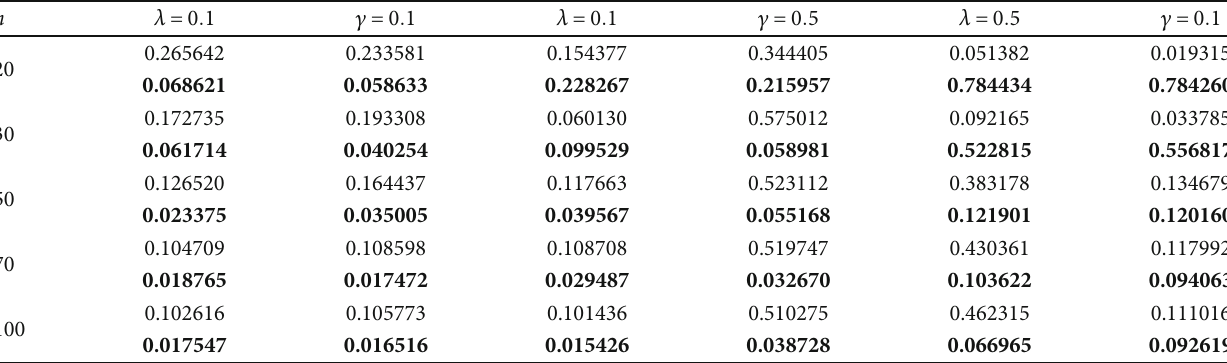
Table 3: BEs and PRs under QLF and noninformative prior using λ = 0 : 1, 0 : 5 and γ = 0 : 1, 0 : 5